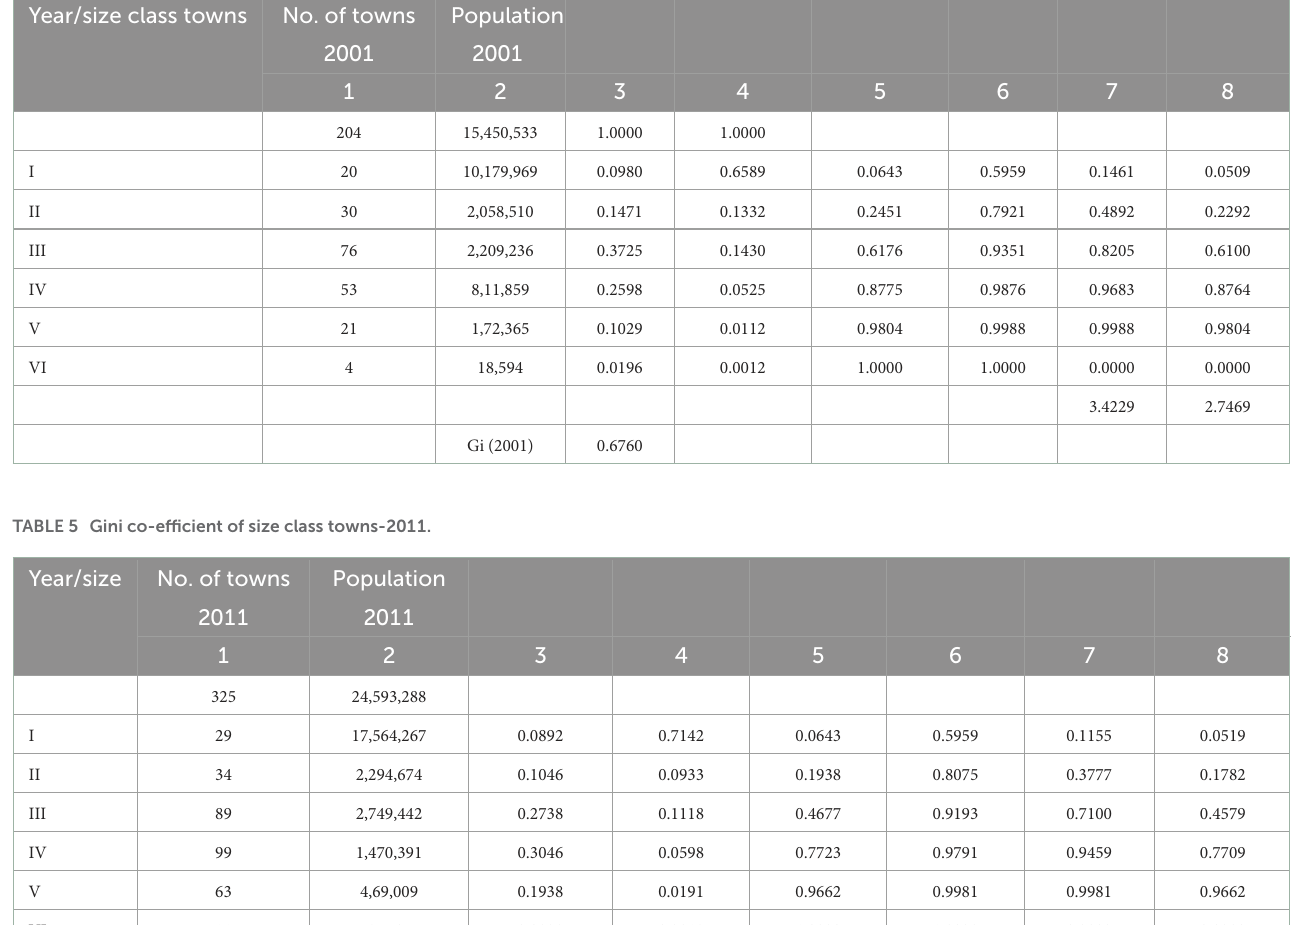
TABLE 4 Gini co-efficient of size class towns-2001.